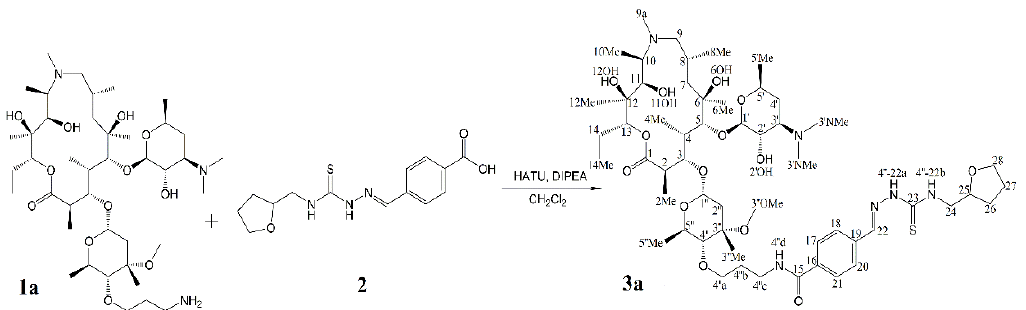
Figure 1. The final reaction step for preparing 4 ″ -tetrahydrofurfuryl macrozone 3a and the atom numbering.